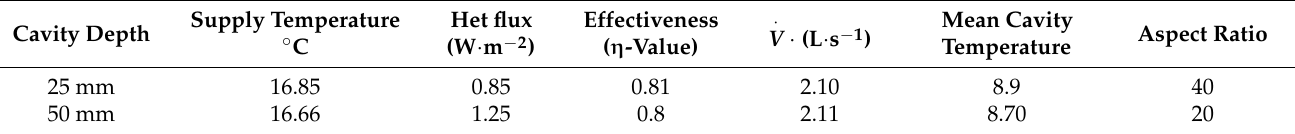
Table 6. Supply air temperature, heat flux, effectiveness, volumetric flow rate, and mean cavity temperature for the ventilated windows with two cavity depth